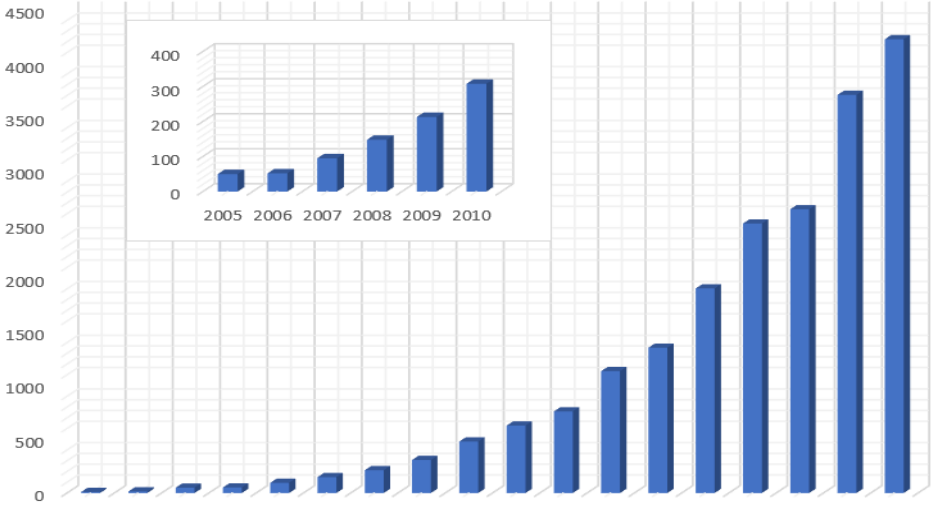
Figure 2. Number of publications on topic